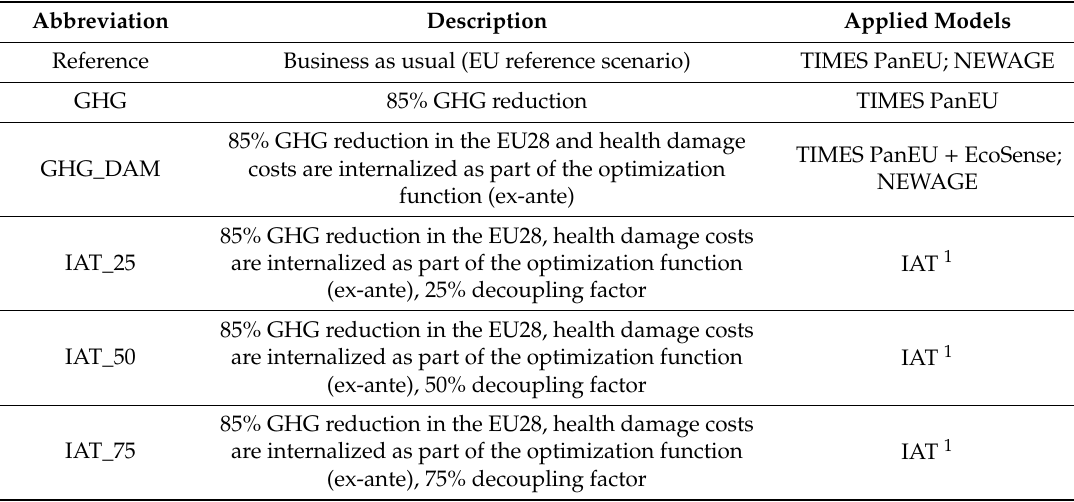
Table 2. Modelled scenarios and their